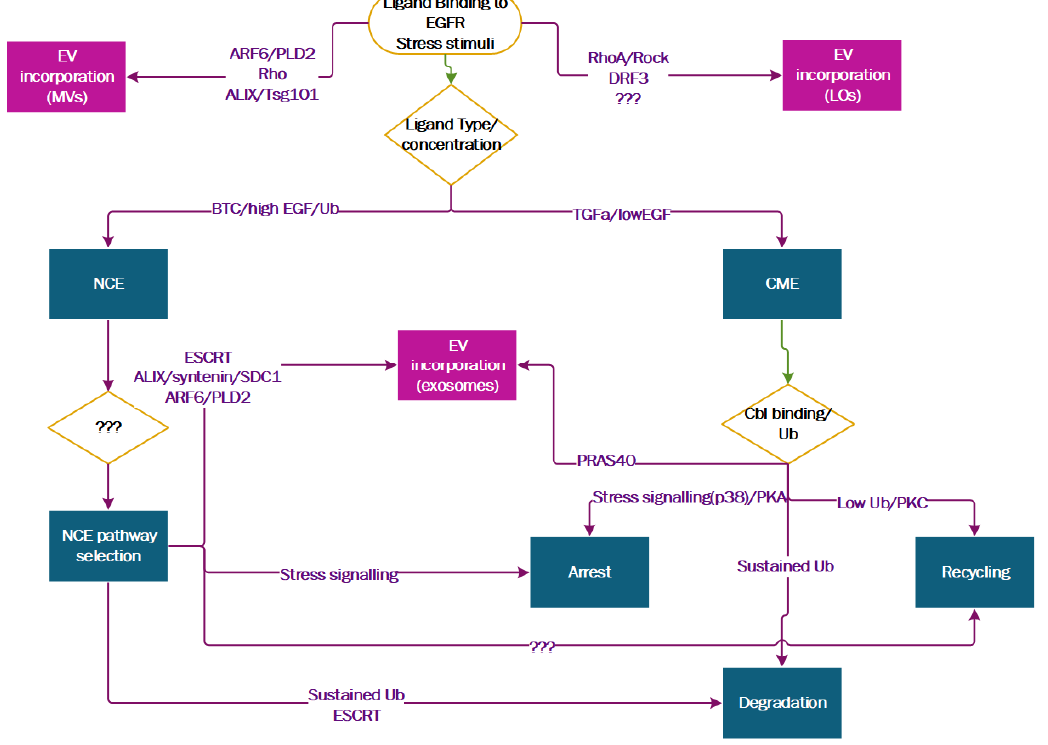
Figure 3. Pathway diagram of EGFR post-endocytic fate.